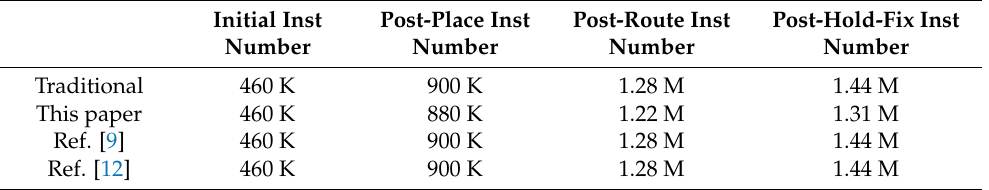
Table 3. Instance count and comparison with existing